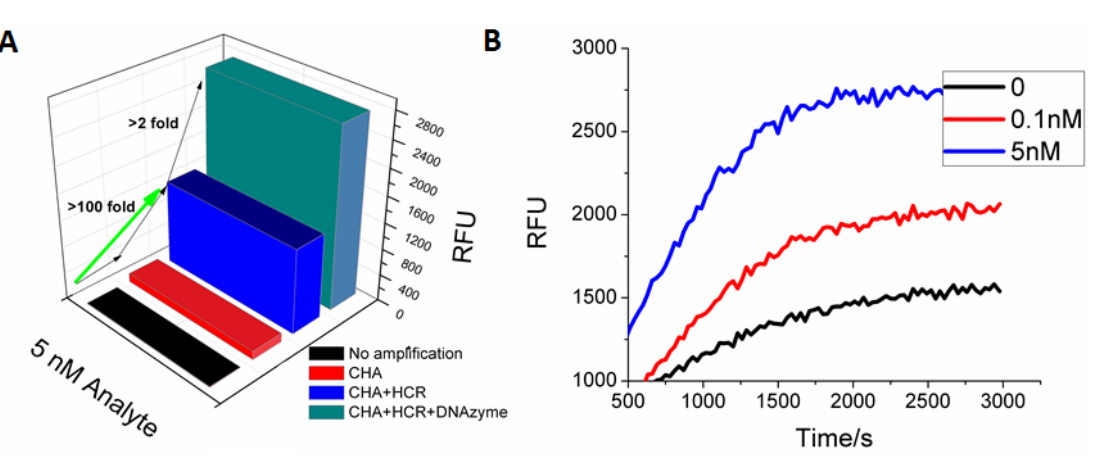
Figure 4. G-quartet-hemin DNAzyme as a reporter for CHA-HCR. ( A ) Steady-state signal comparison between no amplification, CHA amplification, standard CHA-HCR two-layer amplification, and CHA-HCR-DNAzyme amplification. The RFU is the mean of the steady-state data points collected during fluorescence kinetic readings; ( B ) Fluorescent kinetic measurement with CHA-HCR-DNAzyme